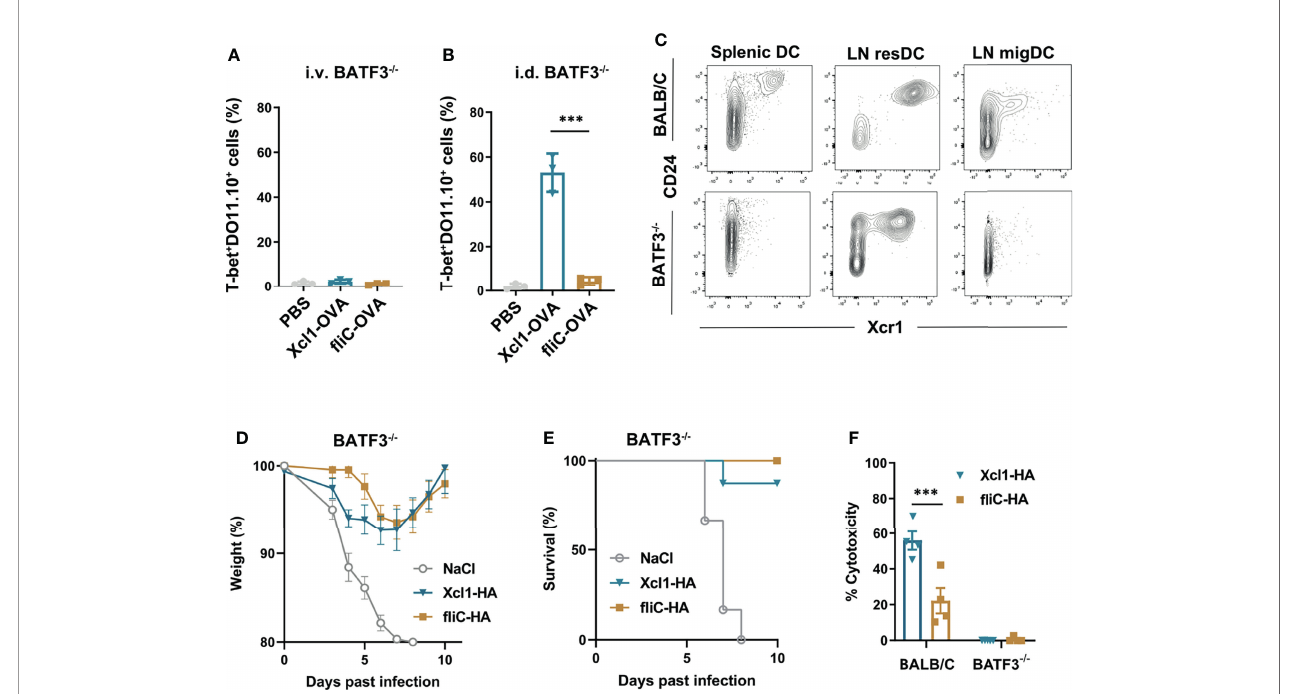
FIGURE 4 | Xcl1-OVA induced Th1 polarization is independent of BATF3. (A, B) BATF3 -/- mice were injected i.v. with 1 × 10 6 naïve DO11.10 cells, and 24 h later (A) given an i.v. injection of either puri fi ed Xcl1- or fl iC-OVA proteins (5 m g) or (B) DNA immunized i.d. with 25 m g plasmid encoding either Xcl1-OVA or fl iC-OVA. The percentages of T-bet + DO11.10 cells evaluated in spleens (A) or in LNs (B) 3 days after immunization. (C) Spleens and inguinal LNs were harvested from BALB/c or BATF3 -/- mice and analyzed for CD24 + Xcr1 + cDC1s by fl ow cytometry after fi rst gating on Lin - MHC-II + CD11c + cells. Migratory DCs were de fi ned as CD11c int MHC- II high and resident DCs as CD11c high MHC-II int ( Supplementary Figure 5F ). (D, E) BATF3 -/- mice were DNA immunized with 25 m g plasmid encoding either Xcl1- OVA or fl iC-OVA and challenged 14 days later with 5xLD50 PR8 virus. (D) Weight and (E) survival was monitored for 10 days. (F) In vivo cytotoxicity after DNA immunization with 25 m g plasmid encoding either Xcl1-OVA or fl iC-OVA in BALB/c or BATF3 -/- mice. Data representative of two (A – C) , pooled from two (D, E) or from one (F) independent experiments with n = 3 samples per group (A, B) , n = 3 – 4 mice per group (C, F) or n = 6 – 8 mice per group (D, E) . Statistical analysis performed using parametric t-test. ***p <